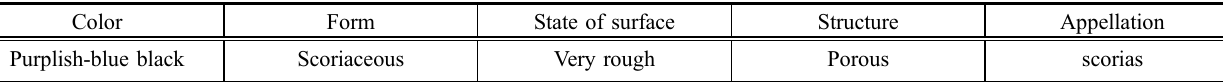
Table 2 Scoria used in the